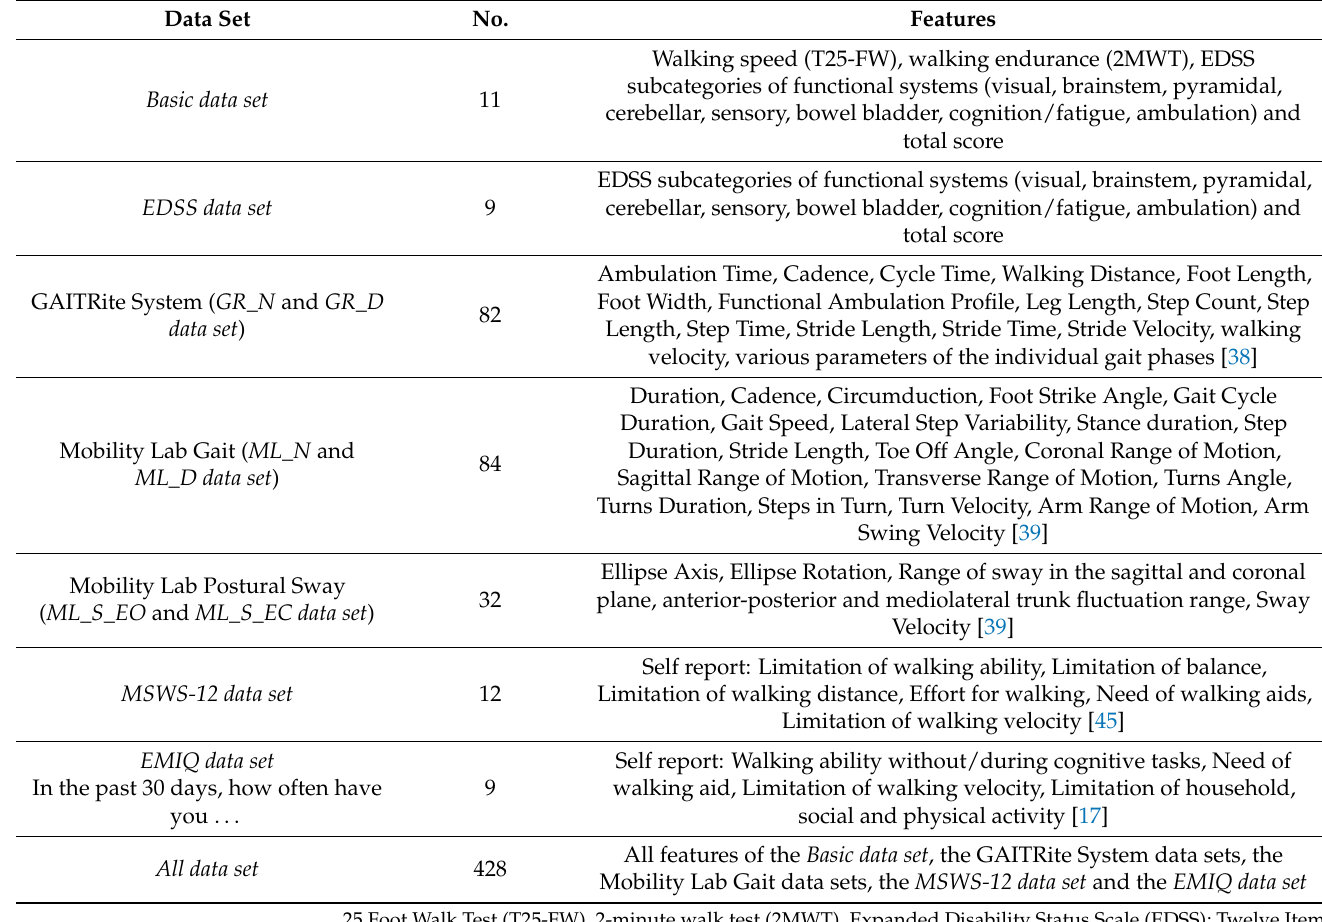
Table 1. Mobility and clinical parameters recorded by the physician or nurse, self-reported gait parameters by patients as well as gait parameters recorded by gait analysis